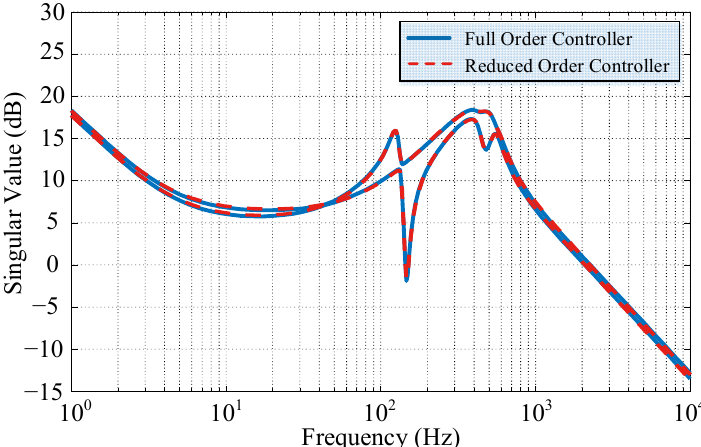
Figure 9. Singular values of the μ -controllers.